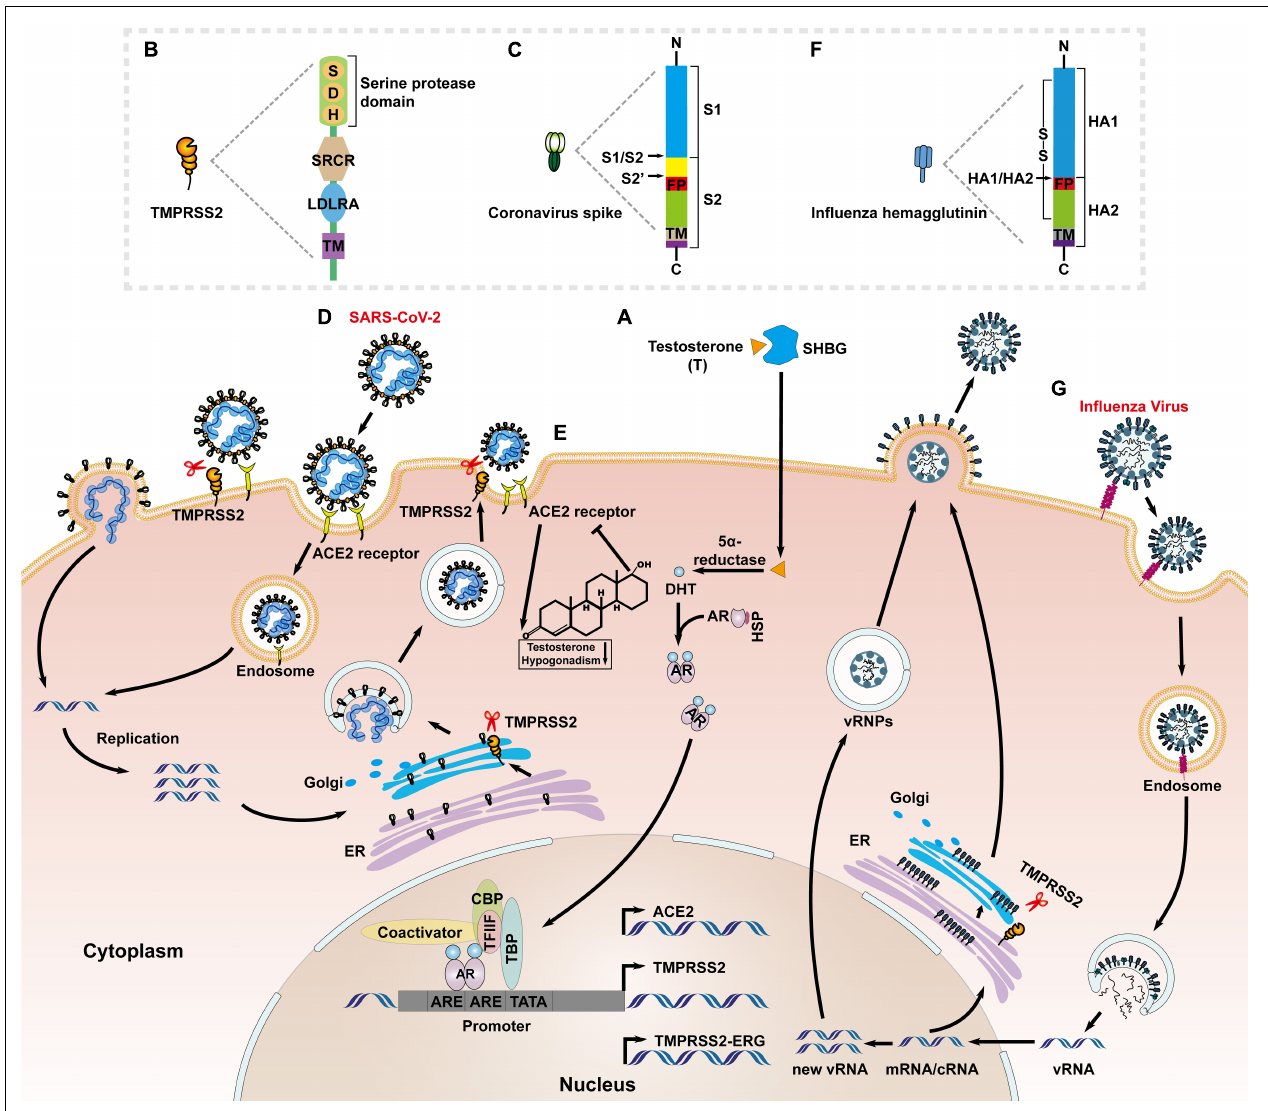
FIGURE 1 | Priming of the SARS-CoV-2 S proteins and HA protein of influenza virus by TMPRSS2. (A) Sex hormone binding globulin (SHBG) transports androgens (mainly testosterone) and mediates cell entry. Intracellular 5 α -reductases induce testosterone to produces active DHT that interacts with AR. The androgen and AR complex enters the nucleus and binds to ARE, then interacts with the TFIIF subunit, RNA polymerase II, TATA-binding polypeptide (TBP), CBP, AR co-activators, and other transcription factors to regulate the transcription of TMPRSS2. (B) The functional domains of TMPRSS2: the serine protease domain containing the catalytic triad consisting of histidine (H), aspartic acid (D) and serine (S); scavenger receptor cysteine-rich domain (SRCR); low-density lipoprotein receptor domain class A (LDLRA); and the N-terminal transmembrane domain. (C) The functional domains of coronavirus S protein: S1 subunit (attachment); and S2 subunit (fusion) including putative fusion peptide (FP) and transmembrane domain (TM); The S1/S2 and S2’ cleavage sites are indicated by black arrows. (D) ACE2 binds to the receptor-binding S protein of SARS-CoV-2 to accelerate the endocytosis of the virus into host cells; ‘TMPRSS2 cleaves the S2’ site of SARS-CoV-2 S protein to promote the direct fusion of viral particles to the cell and release of the viral genome, and activates S protein and cleaves the envelope protein on intracellular Golgi bodies to facilitate virus assembly and release. (E) A negative feedback regulation exist between the androgen/AR and ACE2. Lacking of androgen increases the expression of ACE2 in prostate cancer patients, and in turn ACE2 is constitutively expressed in adult-type Leydig cells which affects the secretion of testosterone. (F) The functional domains of influenza virus HA protein: HA1 subunit; and HA2 subunit including FP and TM; The HA1/HA2 cleavage site is indicated by a black arrow. (G) The HA1 subunit of the influenza virus HA protein binds to the sialic acid receptor to accelerate the endocytosis of virus particles into the cytoplasm. Influenza virus uses the released viral ribonucleoprotein complexes (vRNPs) as a template to transcribe and replicate, and then TMPRSS2 cleaves HA on intracellular Golgi bodies to facilitate virus assembly and